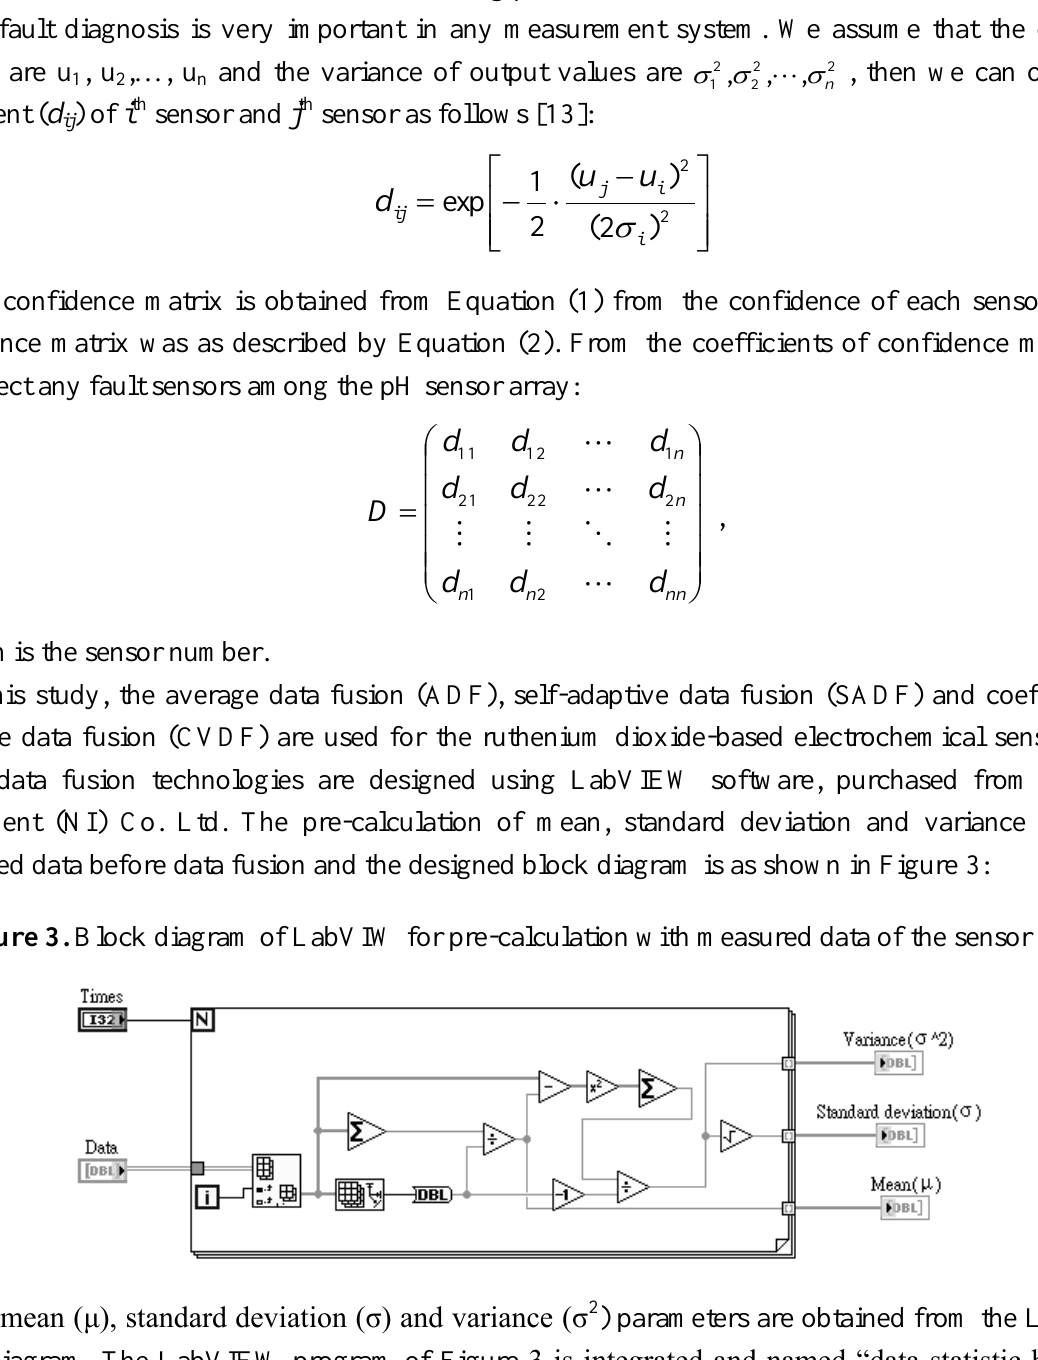
The mean (μ), standard deviation (σ) and variance (σ 2 ) parameters are obtained from the LabVIEW block diagram. The LabVIEW program of Figure 3 is integrated and named “data statistic block.vi”. The data statistic block.vi program diagram is shown in Figure